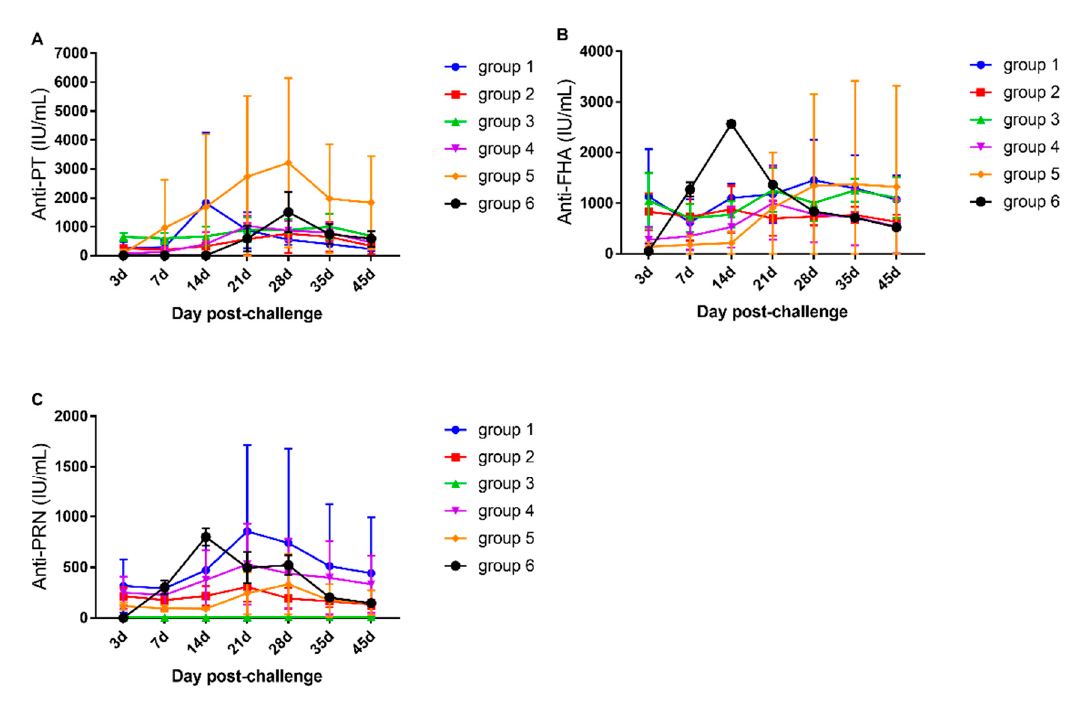
Figure 3. Antibody responses after B. pertussis aerosol challenge in immunized rhesus macaques from different groups. ( A – C ): Anti-PT, anti-PRN, and anti-FHA antibody levels were tested using ELISA. Standard serum was prepared using International Standard for pertussis (Human resource) (NIBSC code: 06/140, from NIFDC)